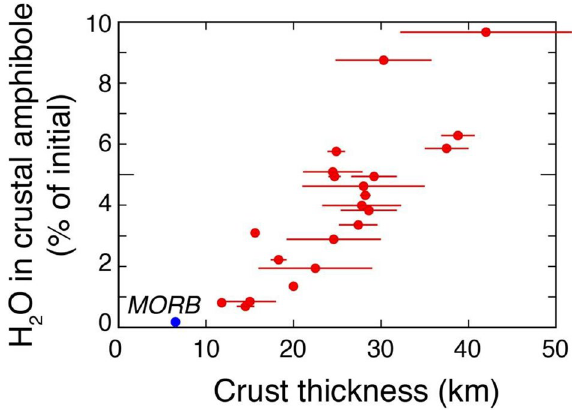
Figure 7. H 2 O stored in amphibole crystallized within the crust versus crustal thickness. H 2 O is the percentage of the initial H